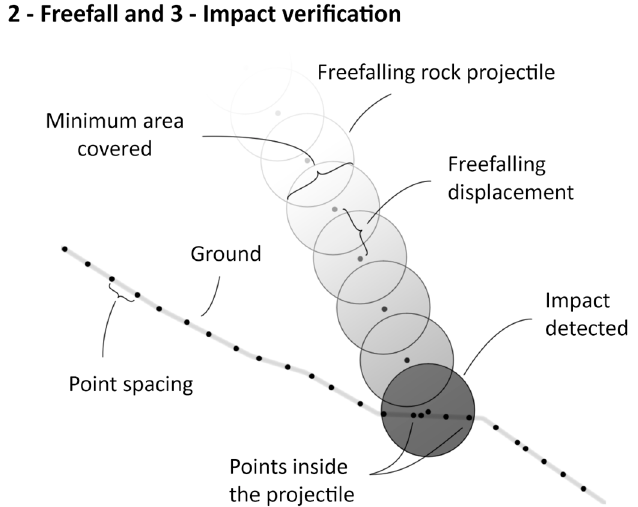
Figure 8. Algorithm steps 2 and 3. Freefalling positions are shown in gradations of gray. Impact verification is performed for each position. An impact is detected when there are points inside the falling rock. The point spacing must be smaller than the width of the minimum area covered and generally provides the optimum results at ¼ of d 1 .